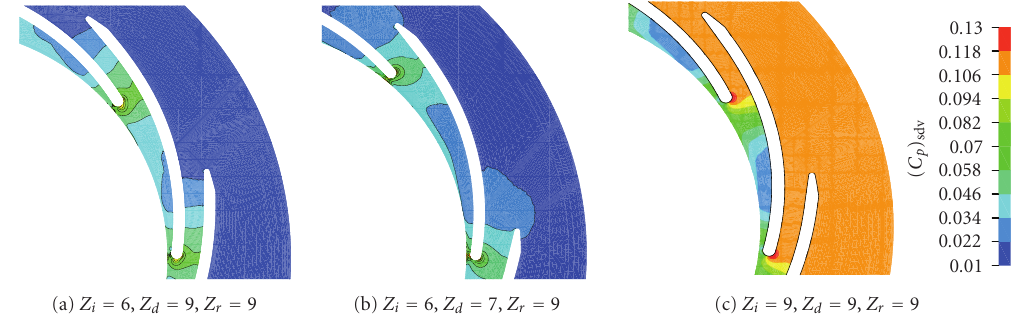
Figure 15: Pressure fluctuation in the di ff user region, midspan.